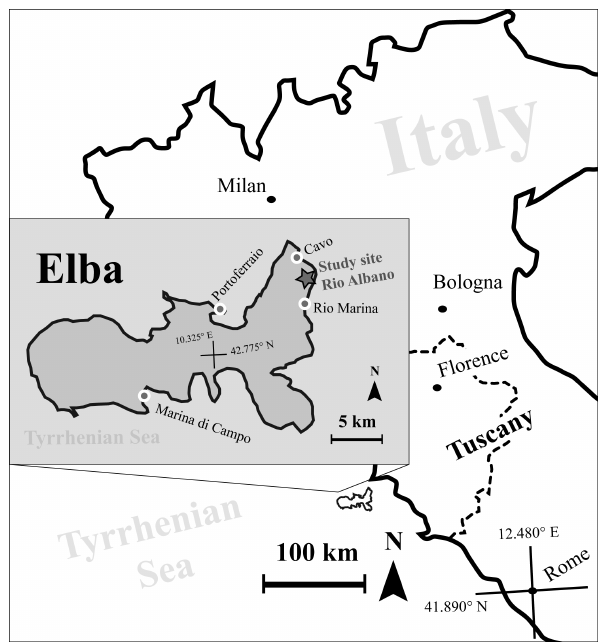
Figure 1. Location of the study